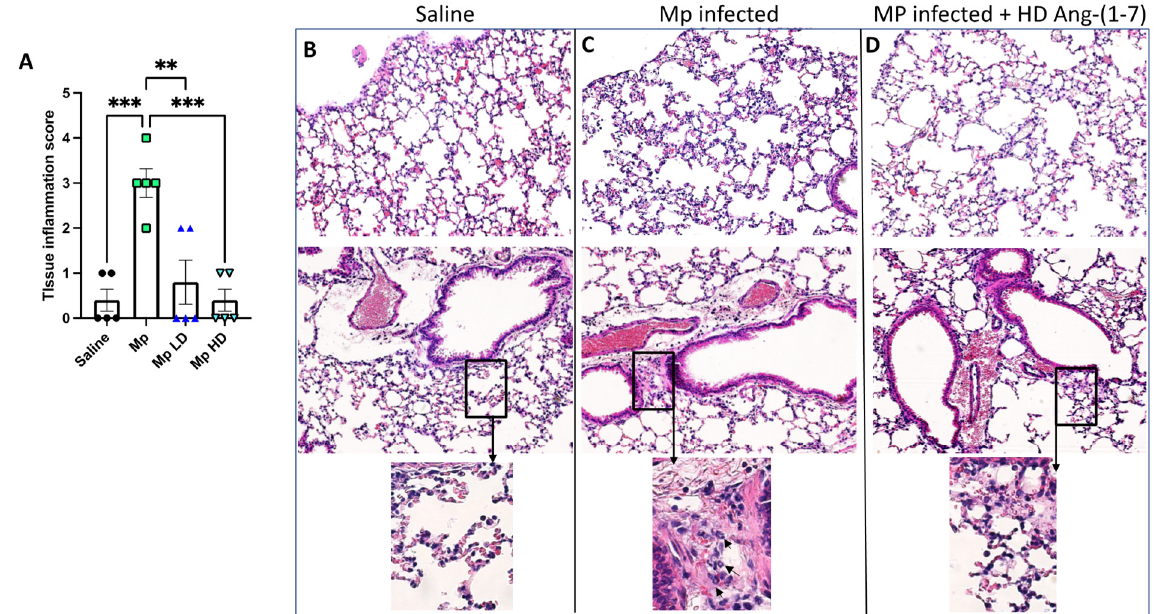
Figure 4. The effect of Ang-(1–7) on pulmonary inflammation in H&E stained slides of sectioned mouse lung. ( A ) Average grade scores for each experimental group. Data are expressed in mean ± SEM. n = 5 mice/group. Representative H&E stained lung sections at 20X magnification from ( B ) saline vehicle, ( C ) Mp infection only (arrows in boxed enlargement indicate neutrophils), ( D ) Mp infection with high dose Ang-(1–7) treatment. ** p < 0.01, *** p < 0.001 by one-way ANOVA for multiple comparisons.